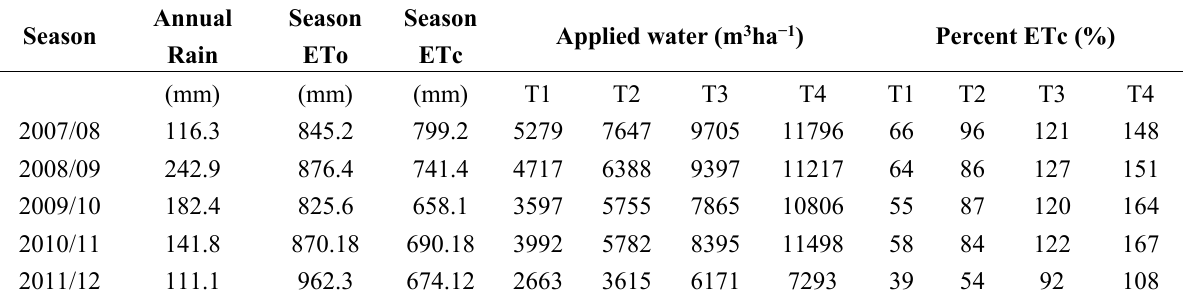
Table 1. Seasonal precipitation, seasonal reference evapotranspiration (ETo), seasonal crop evapotranspiration (ETc), applied water and percentage of ETc in each experimental